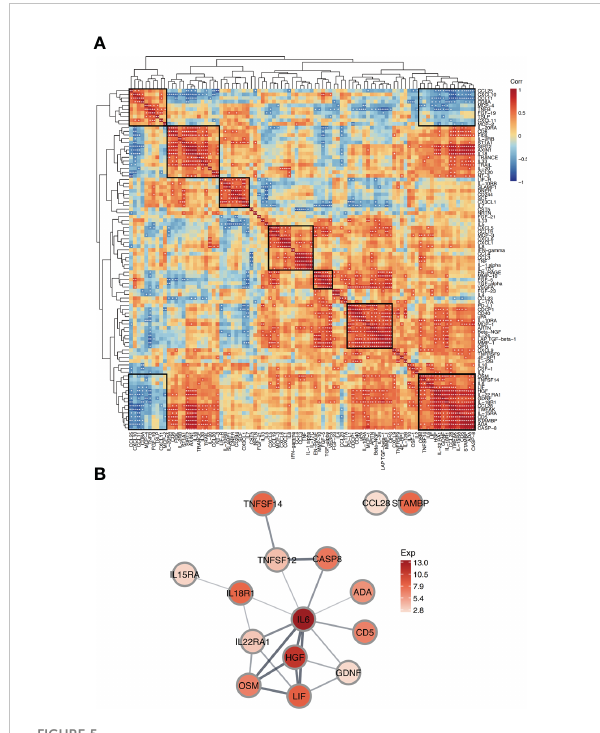
FIGURE 5 Correlation and interaction of proteins in FBG. (A) Correlation Heatmap depicts pairwise Pearson correlation coef fi cient values between proteins in FBG. Protein modules with high intercorrelation are marked with boxes. The rows and columns are grouped by hierarchical clustering. *p<0.05; **p<0.01. (B) Protein-protein interaction network shows predicted interactions between a group of proteins. Node colors represent average protein expression in FBG and edge weights indicate con fi dence level (strength of data support for the